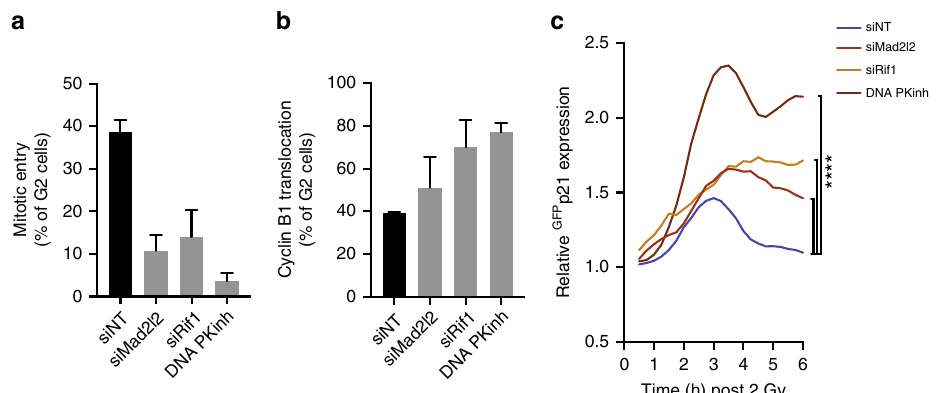
Fig. 5 Disrupting DNA repair ef fi ciency drives cell cycle exit. a Mitotic entry scored in RPE CCNB1 YFP cells within 15 h following IR (2 Gy). Average of three independent experiments + sem. b Percentage of RPE CCNB1 YFP cells that translocate Cyclin B1 after IR (2 Gy). Average of three independent experiments + sem. c Induction of GFP p21 expression after IR (2 Gy) upon depletion or inhibition of the indicated repair proteins. Mean lines from pooled individual cells from two independent experiments, n > 50 cells per condition, signi fi cance by 2-way